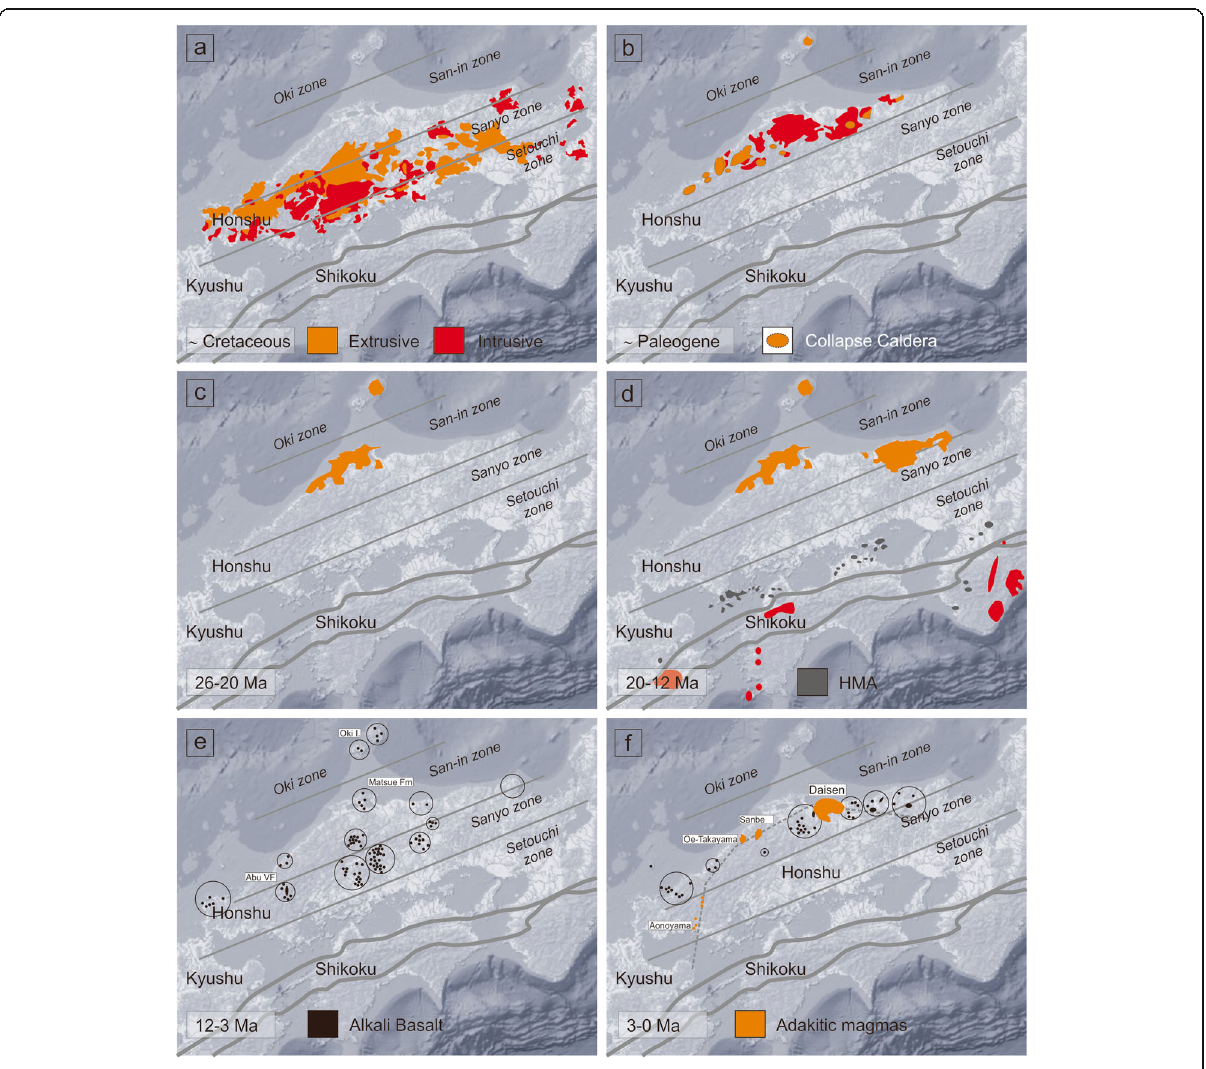
Fig. 3 Magmatic evolution of the SW Japan arc segment (detailed description of individual stages in the text) a : Continental arc stage, formed by a large number of granitic intrusions and associated extrusive rocks, of mainly Cretaceous age. b : Paleogene continental arc stage (second igneous flare up) which precedes the subsequent rift initiation. Many of the volcanic successions of this stage are preserved in relation with collapse caldera structures. c : Back-arc rift initiation starting with continental volcanism – subsequently changing to sub lacustrine / marine stages. d : Ongoing (mainly submarine volcanism in the back-arc basin with contemporary onset of diverse igneous activity in the fore-arc, marking the beginning subduction of the PSP. e : Evolution of several monogenetic volcanic fields, mainly alkali basalt volcanism. f : Ongoing monogenetic alkali basalt volcanism and coeval evolved adakitic magmatism (Nakajima 1996; Kimura et al. 2005a; Imaoka et al. 2011; Sato et al.